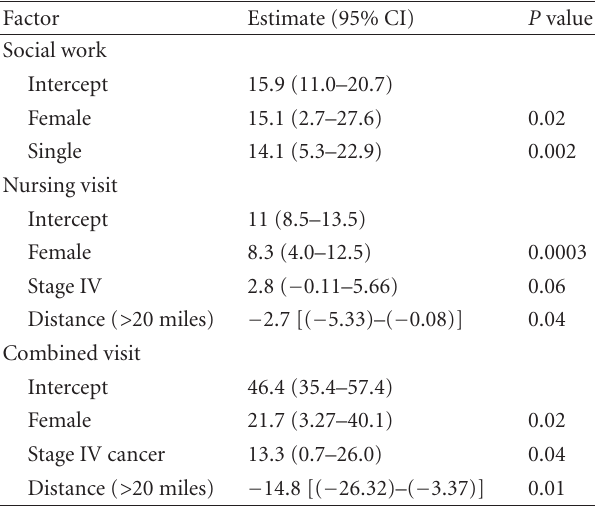
Table 7: Multivariate regression